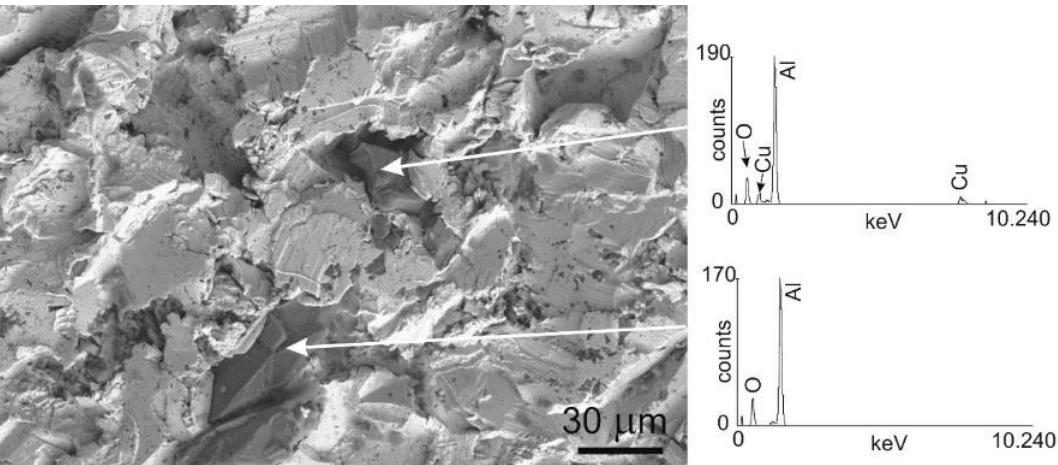
Figure 5. SEM image of a representative sandblasted copper sample, the arrows show the alumina particles. On the right, EDS analysis of chemical composition insets.